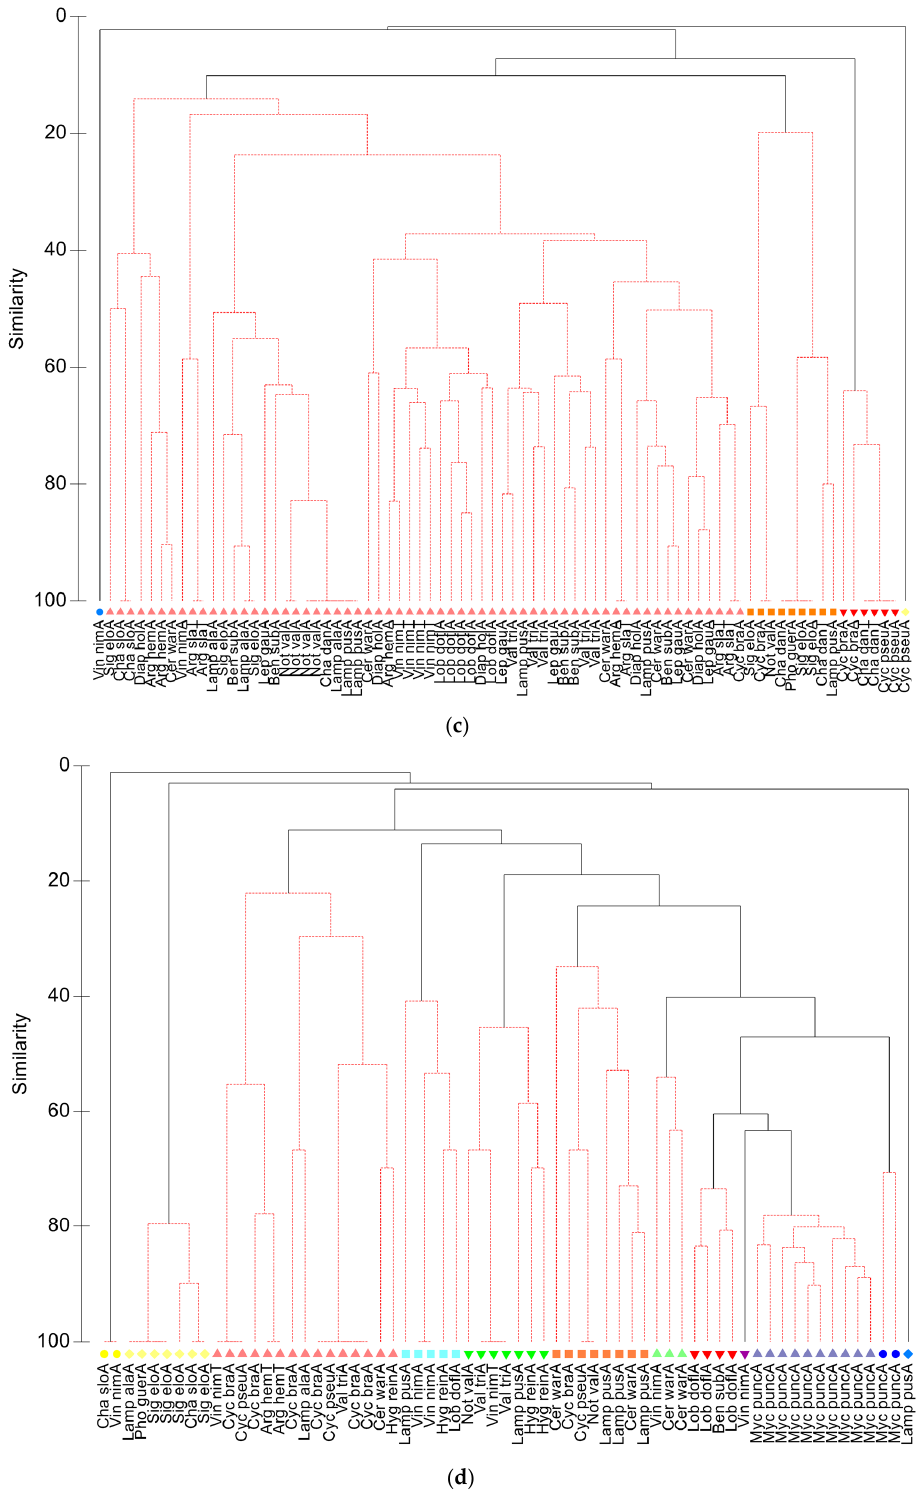
Figure 3. Four dendrograms showing significant groupings for fish diets in each zone, apart from Galicia, after applying cluster analyses to the Bray–Curtis similarity and transformed matrixes of prey abundances. Significant clusters are denoted by colored symbols and black lines (SIMPROF, p = 0.05). Dashed lines depict non-significant clusters. Labels indicate the shortened name of the species (first three/four letters of the genus and species) and the developmental attribution: T: transfor- mation; and A: adult (including juveniles). Zones: ( a ) Balearic; ( b ) Alboran; ( c ) Cadiz; and ( d ) Lisbon. In the Atlantic waters of the Gulf of Cadiz, three significant groups were detected.